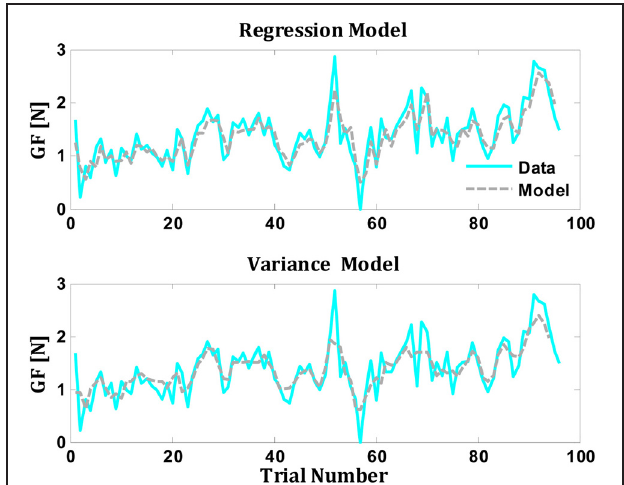
FIGURE 4 | Comparison between predictions of the regression and variance models for grip force from single subject (Data from Mawase and Karniel, 2010). The gray line represents the actual performance of the subject, while the colored line represents the model’s prediction (upper panel for regression model and the lower panel for the variance